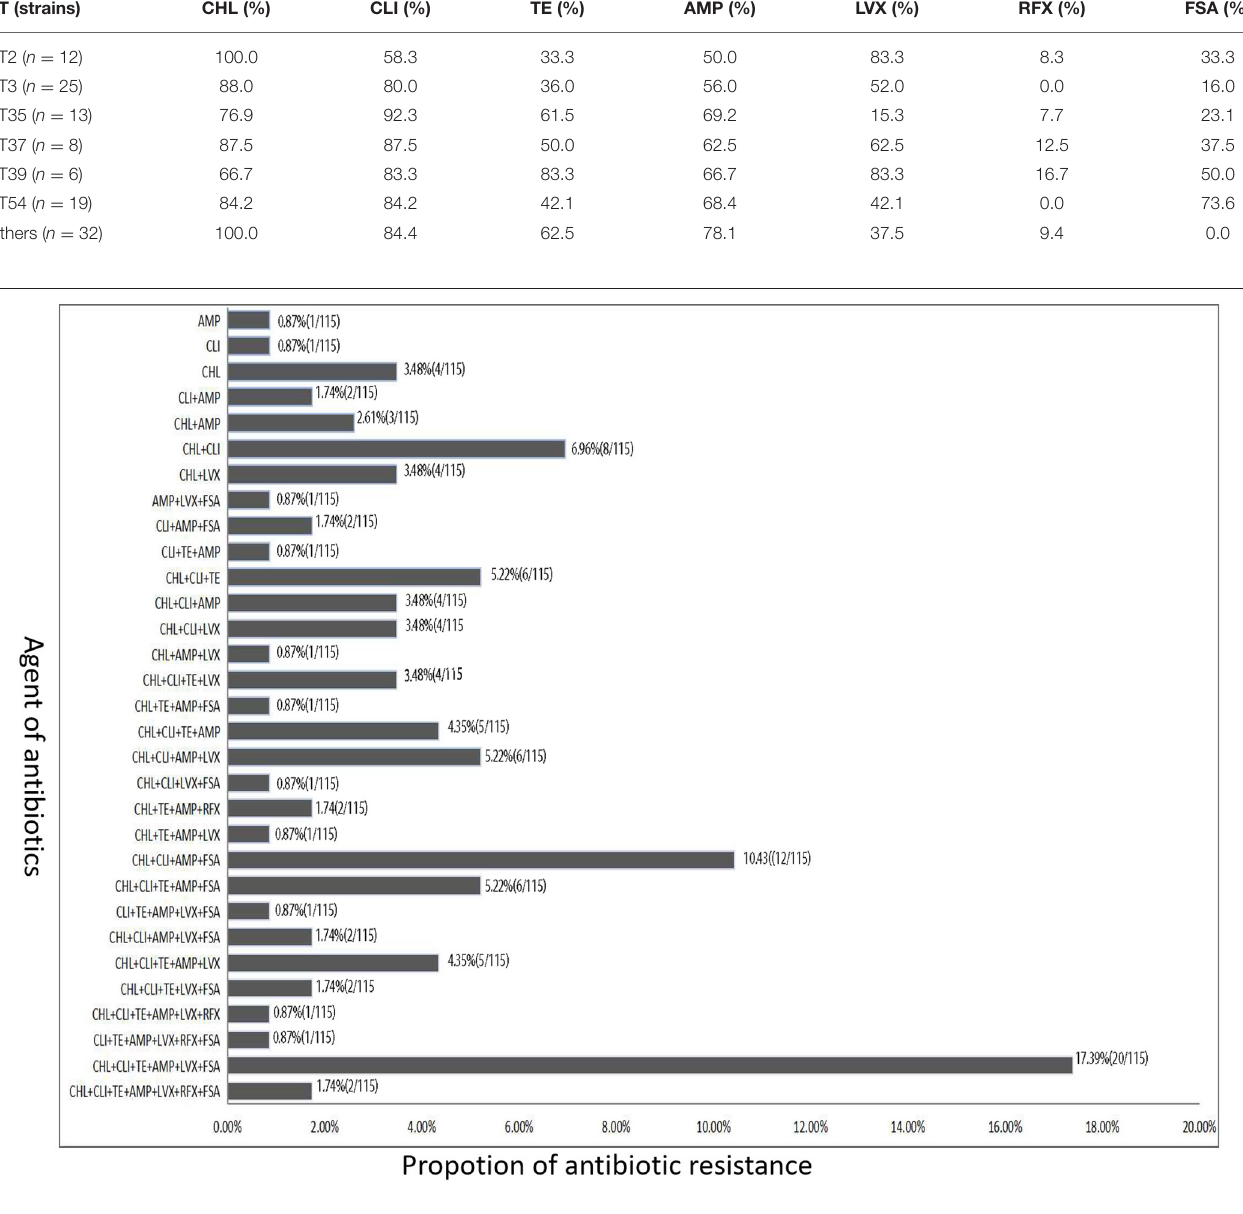
FIGURE 3 | The antibiotic resistance type of toxigenic C. difficile isolates according to the difference of resistance to different types of antibiotics.